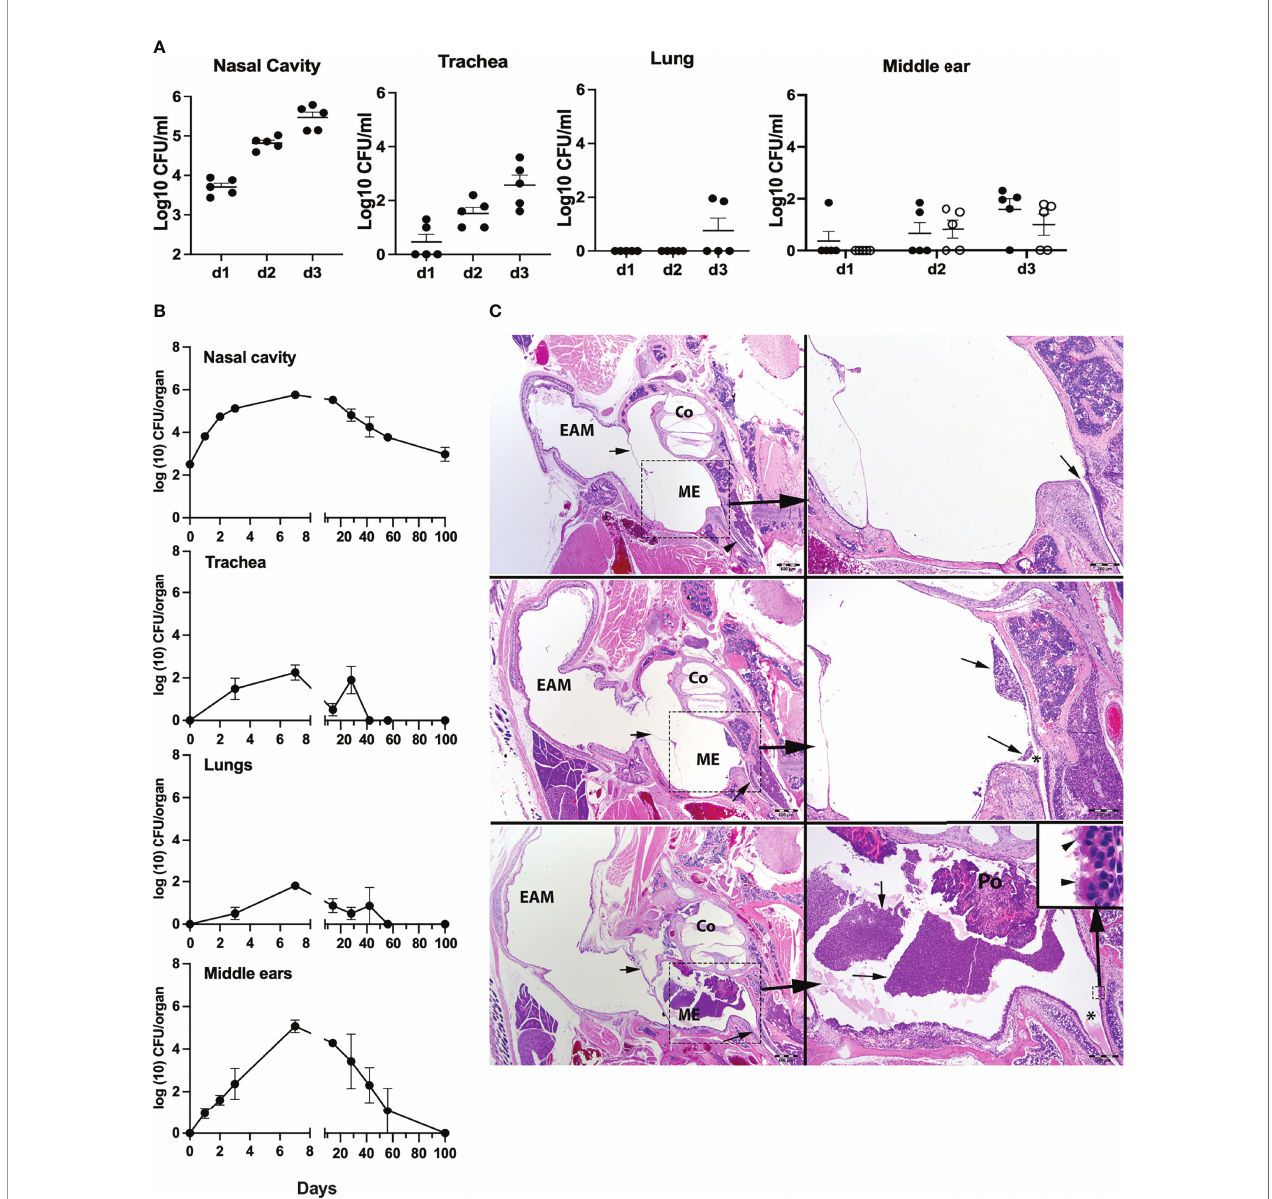
FIGURE 1 | Colonization and growth of Bordetella bronchiseptica in the respiratory tract and middle ears of C57BL/6J mice. (A) Graphs represent the B . bronchiseptica colony-forming units (CFUs) recovered (log 10 /ml) from the nasal cavity, trachea, lungs, and middle ears (left to right) from individual C57BL6J mice ( fi lled circles, n = 5 per group). For the middle ears, circles represent bacteria recovered from the left ( fi lled circle) and right (open circle) middle ear bulla of an individual mouse. (B) Graphs represent the number of CFUs recovered over time from the nasal cavity, trachea, lungs, and middle ears of groups of C57BL/6J mice ( n = 4 per group). Filled circles represent the mean value ± SEM. (C) Images represent developing in fl ammation in the middle ears from C57BL/6J mice. HE stains. Top panel : uninfected. In the left image, the small arrows point to the tympanic membrane, and in the lower right, to the Eustachian tube as it enters the middle ear. Scale bar = 500 m m. The right-side image represents higher magni fi cation of the dashed boxed region of the middle ear. Scale bar = 200 m m. Middle panel : 3 dpi with B . bronchiseptica . The left image, the small arrows point to minimal accumulation of in fl ammatory exudate within the middle ear. Scale bar = 500 m m. The right-side image represents higher magni fi cation of the dashed boxed region of the middle ear. Arrows point to minimal accumulation of neutrophils and macrophages arranged about or near the Eustachian tube (*) as it enters the middle ear. Scale bar = 200 m m. Lower panel : 7 dpi with B . bronchiseptica . In the left image, the arrowhead points to a moderate accumulation of in fl ammatory exudate within the middle ear. Scale bar = 500 m m. The right-side image represents higher magni fi cation of the dashed boxed region of the middle ear. Arrows point to a densely cellular collection of neutrophils and macrophages arranged about or near the Eustachian tube (*) as it enters the middle ear, just below an ear polyp (Po; incidental fi nding). Scale bar = 200 m m. Inset (small dashed box): Bacteria attached to the cilia (arrowheads) on the epithelia lining the middle ear by the entrance of the Eustachian tube. Scale bar = 10 m m. EAM, external auditory meatus; Co, cochlea; ME, middle ear in bony tympanic